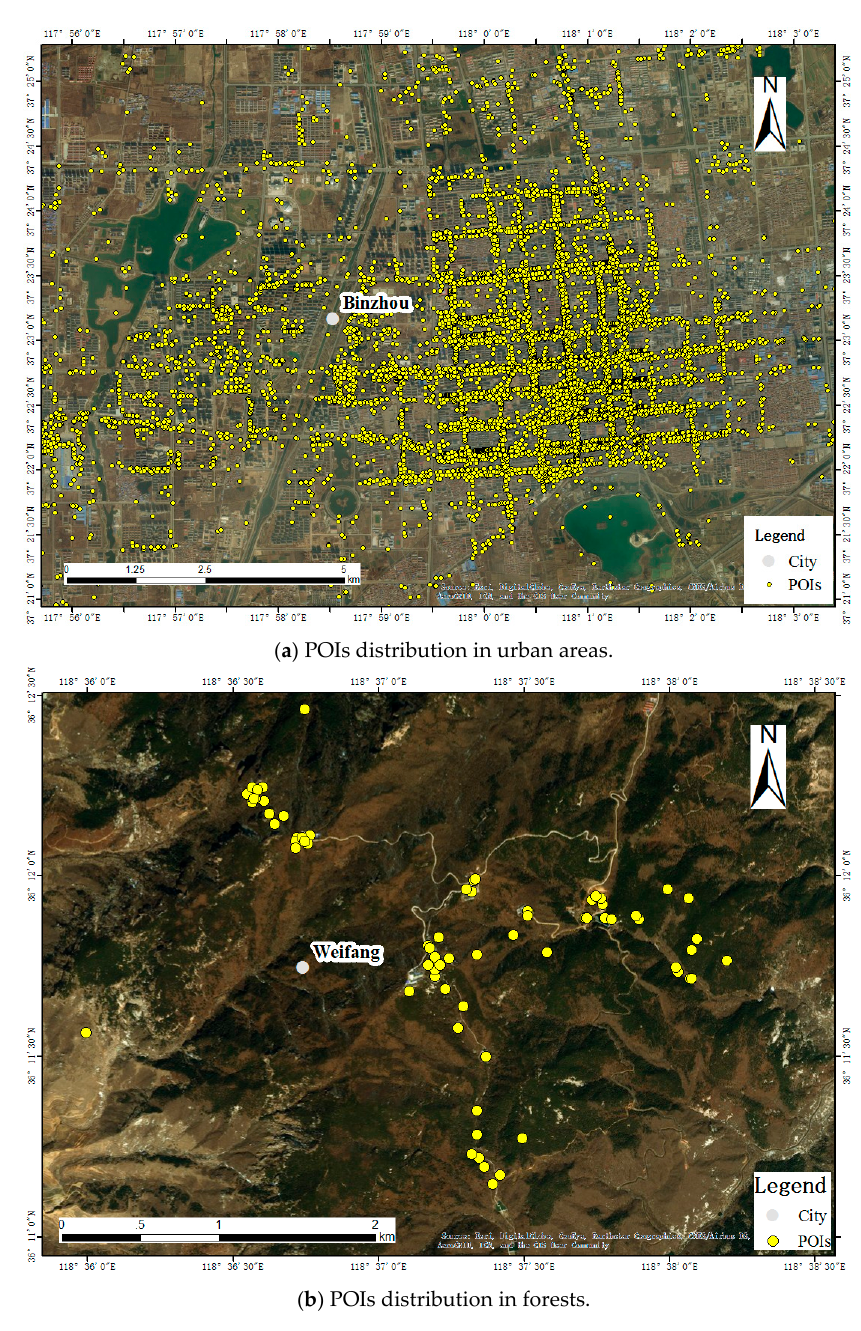
Figure 2. The distribution of POIs (Points of Interest) in two areas in Shandong Province.